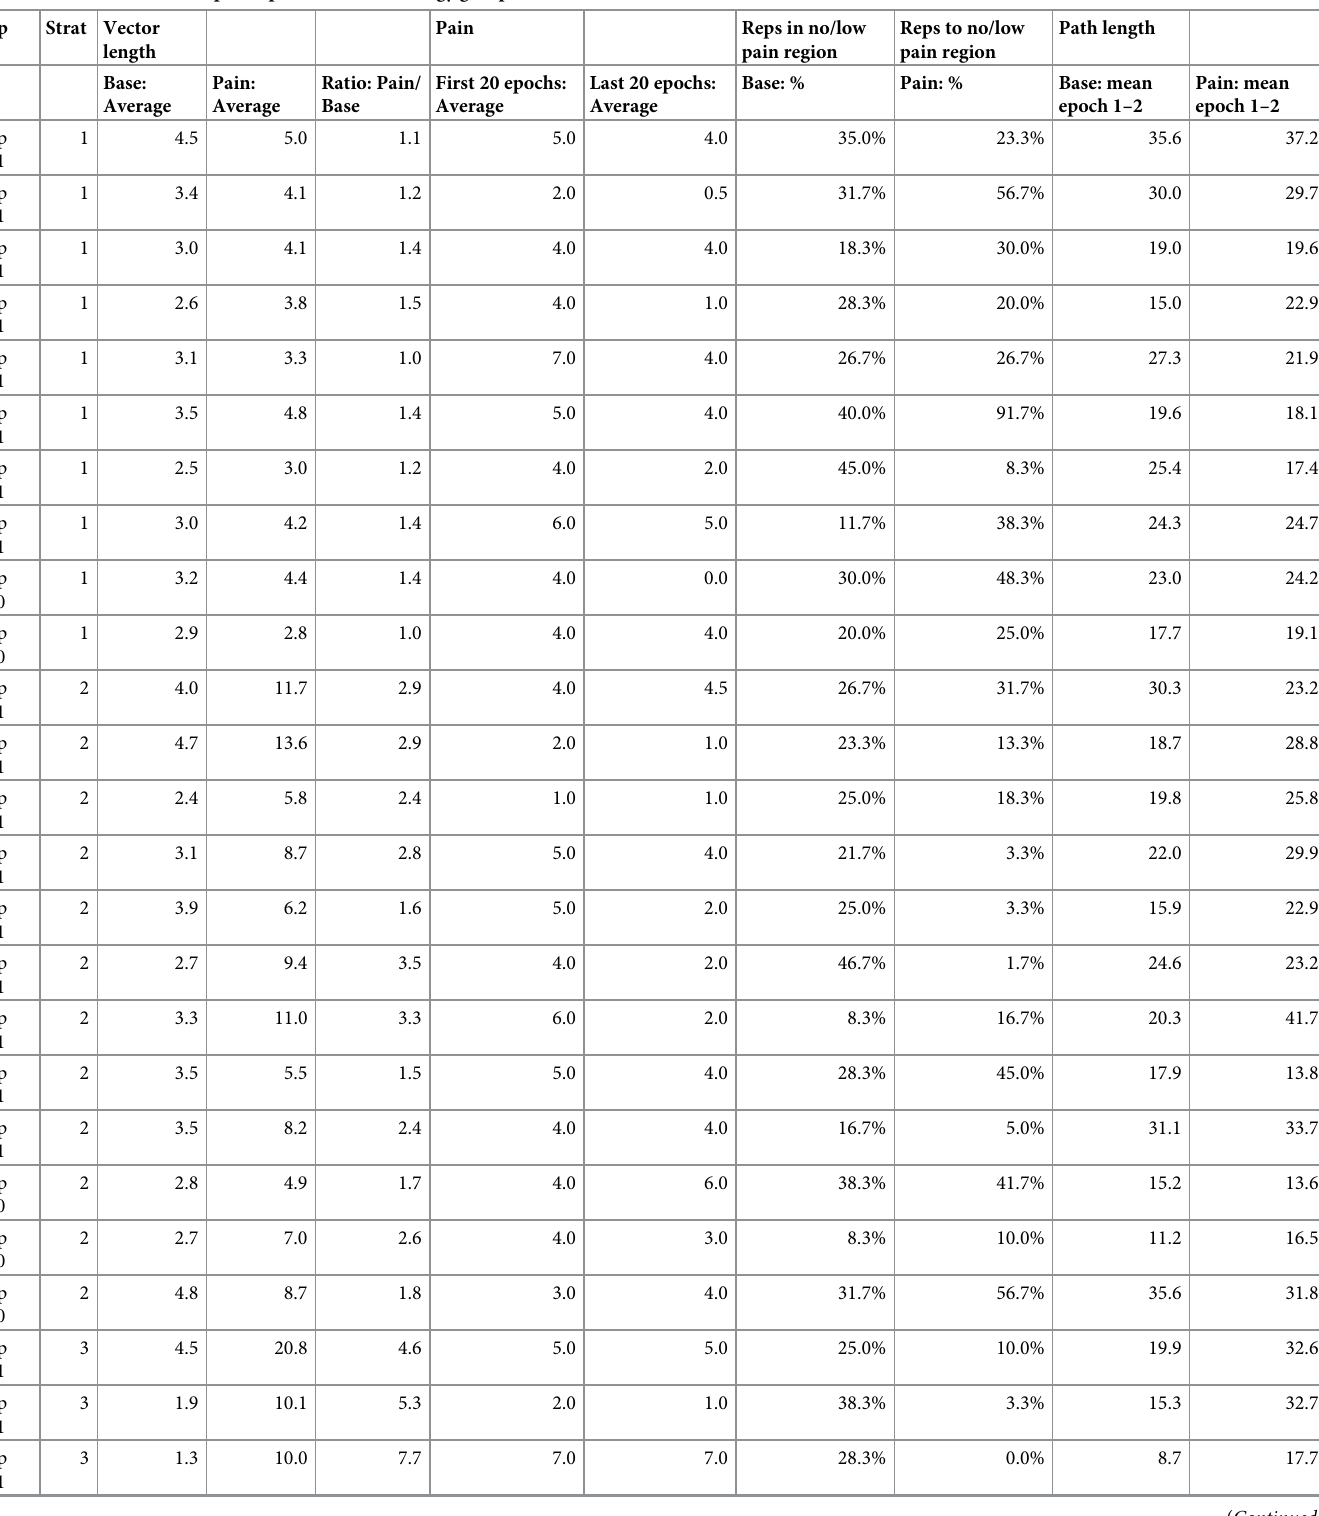
Table 1. Data for individual participants for each strategy